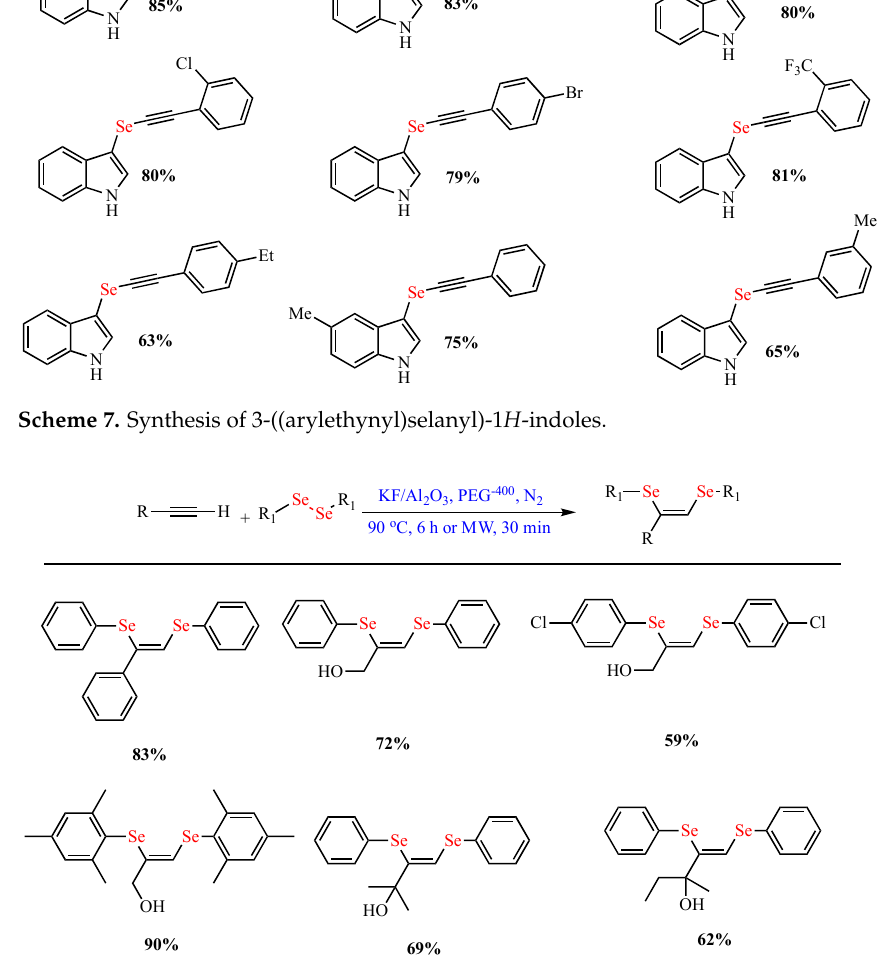
Scheme 8. Synthesis of ( Z )-1,2-bis-arylselanyl alkenes. De Oliveira et al. reported the ytterbium(III)-catalyzed (Yb(OTf) 3 ) synthesis of 2,4- disubstituted Se-quinoline derivatives via Povarov MCR between ethyl glyoxylate, p -anisidine, and ethynyl(phenyl)selane in CH 3 CN as the solvent at 80 ◦ C and in moderate yields (up to 69%) (Scheme 9)